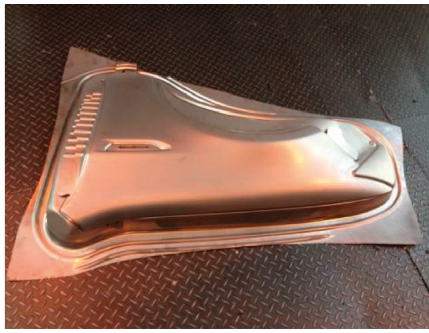
Figure 10: Fender product diagram.